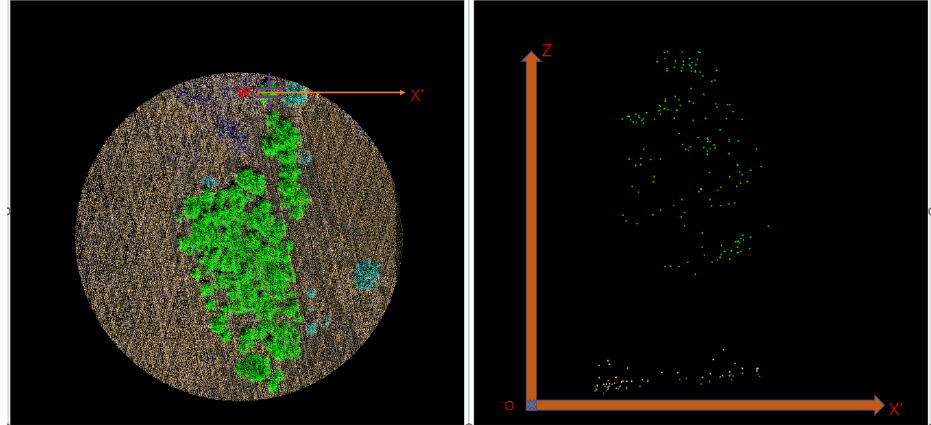
Figure 11. The generation of the profile points of the tree crown, X (cid:48) is the direction of the profile.